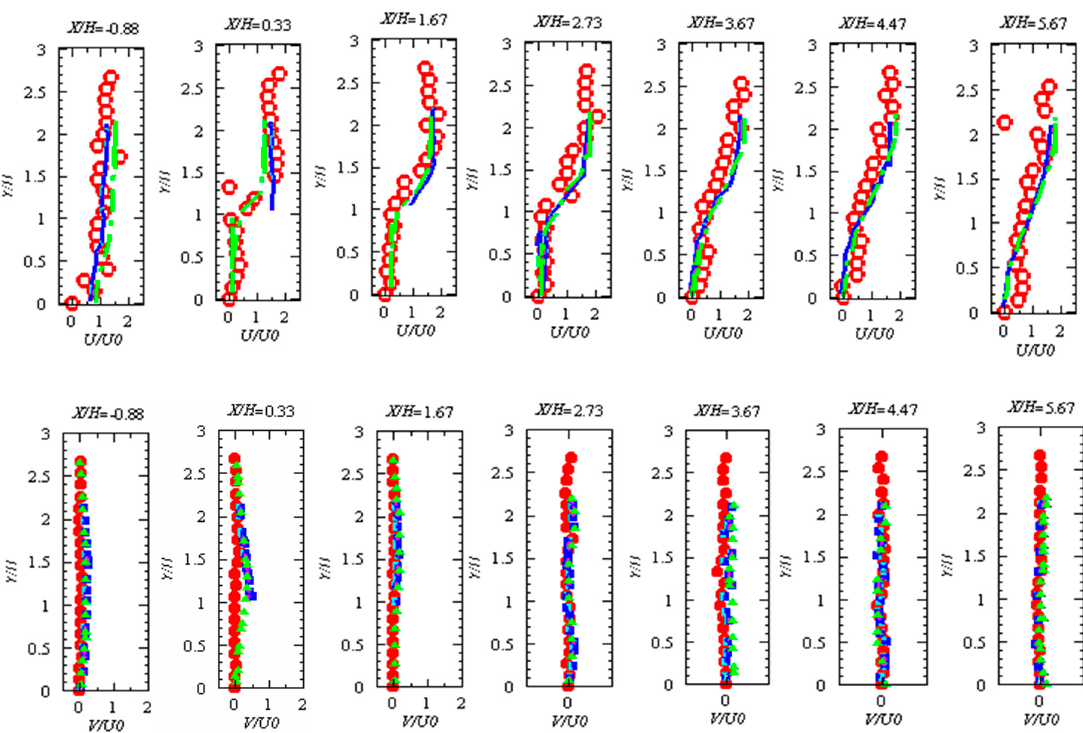
Figure 6. Comparison of longitudinal and vertical velocity for porosity 0.475. Legend: Red open circle: numerical simulation of longitudinal velocity of smooth particle hydrodynamics (SPH); Green dash dot: numerical simulation of longitudinal velocity presented by Chan et al. [7]; Blue solid line: experimental longitudinal velocity values from Chan et al. [7]; Red solid circle: numerical simulation of vertical velocity of SPH; Green solid triangle: numerical simulation of vertical velocity of Chan et al. [7]; Blue solid square: experimental vertical velocity values from Chan et al. [7]. H: water depth (m); U: longitudinal flow rate (m/s), V: vertical flow rate (m/s), U0: Inlet boundary velocity (m/s). X is the distance between the particle and the left boundary of the pore structure, H is the height of the pore structure, and X/H is a dimensionless treatment of the X axis. The pore structure is placed at the origin of this system.